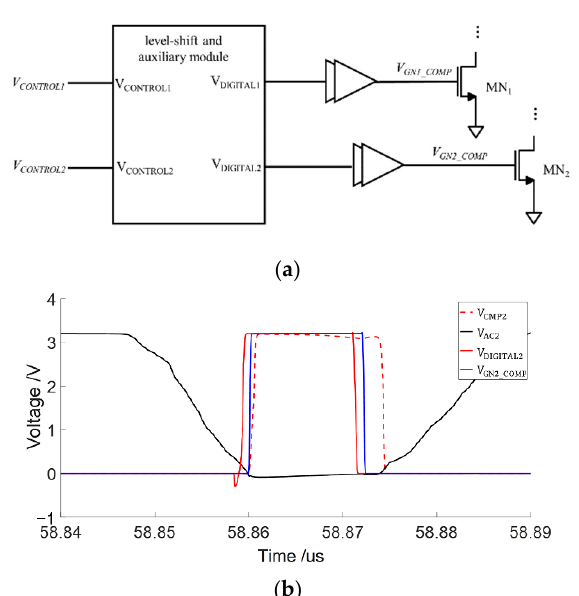
Figure 12. ( a ) The schematic of the drive control circuit and ( b ) the waveforms of main signals.